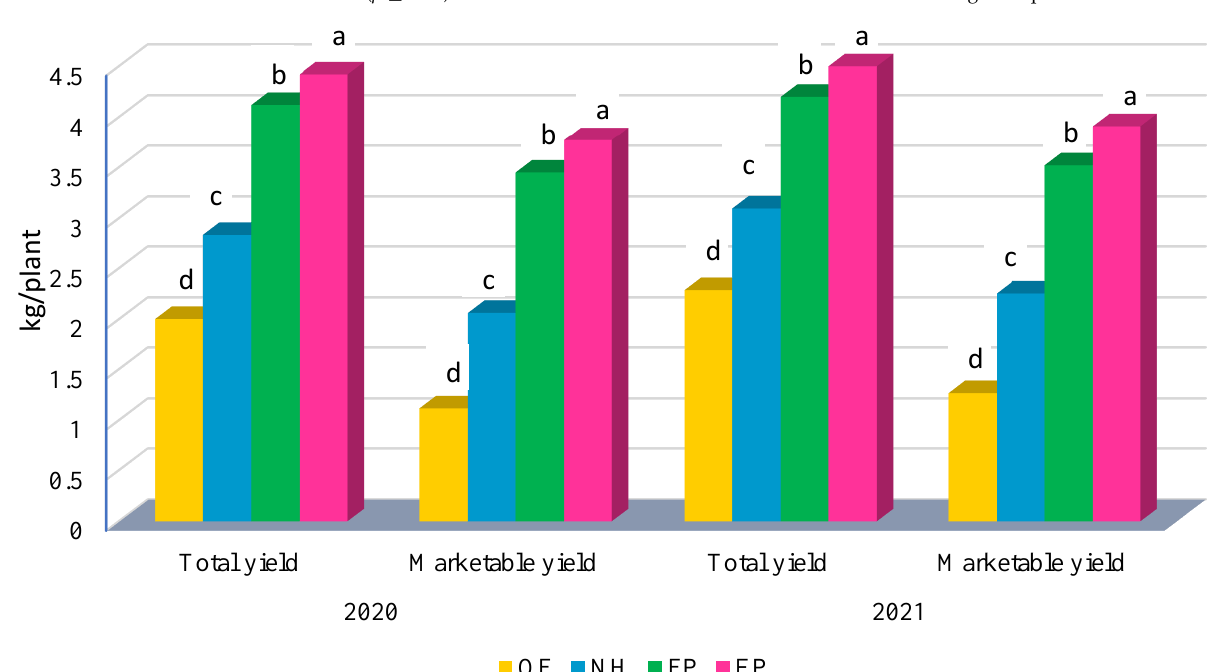
# NH = net. house covered by white mesh insect-proof net with 35% shade level, NF = net house with fogging (operating 6 S/36 S from 10 a.m. to 4 p.m.) and EP = evaporative cooling under plastic house. * BER = blossom-end rot. ˆ IWT = internal white tissue. Different letters in the same column indicate that means are significantly different ( p ≤ 0.05). Standard error of the means was derived from three biological replicates.